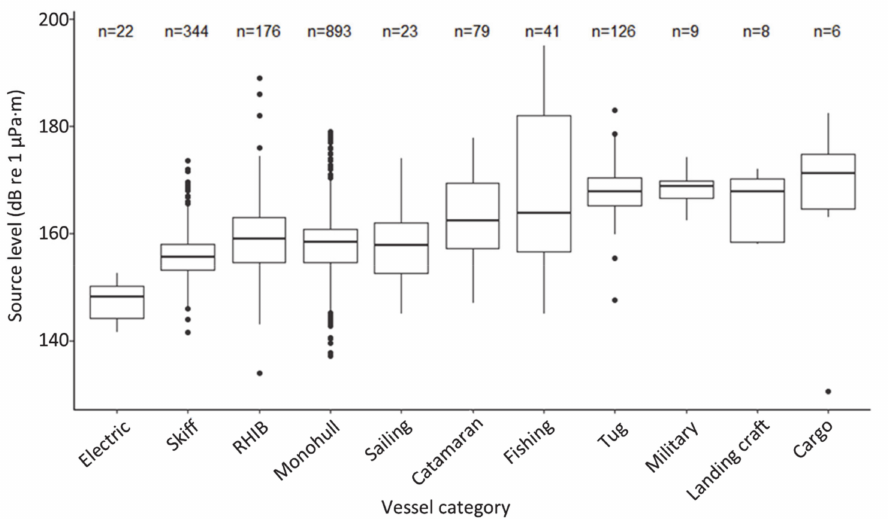
Figure 2. Reported source levels of vessels, segregated by Vessel Type, showing mean, inter-quartile, 5th/95th percentiles and outliers (thick black line, upper/lower bounds of boxes, upper and lower extents of vertical lines, and dots, respectively). Number of samples (n) available for each vessel type before data cleaning